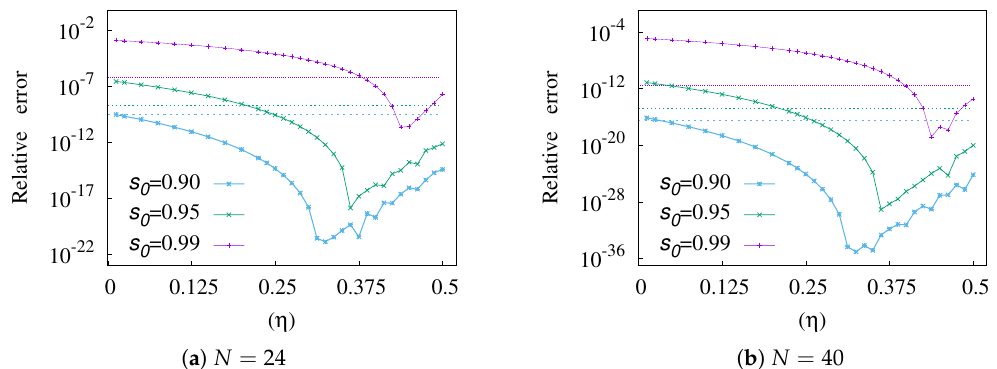
Figure 7. Relative errors of F m ( η ; t ) , 0 < η < 1 in Example 3. Dotted horizontal lines indicate relative errors of Φ 3 ( t ) corresponding to the chosen values of s 0